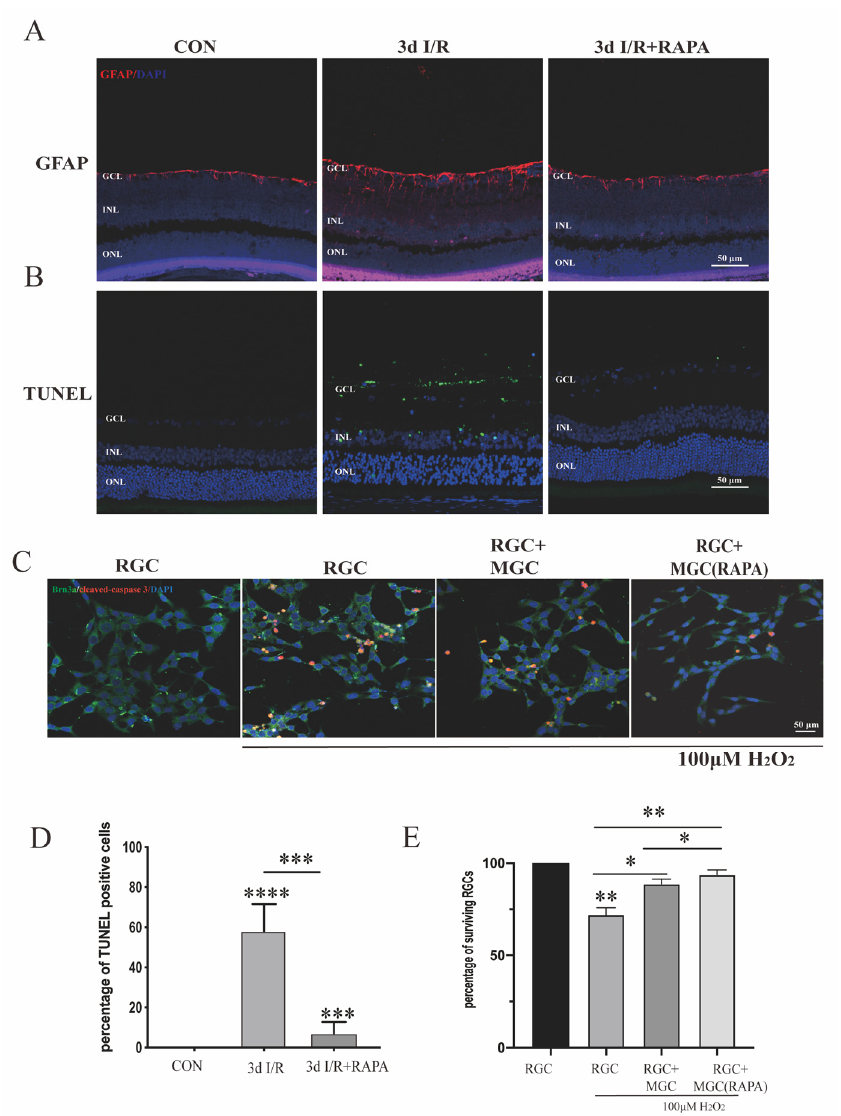
Figure 4. Rapamycin treatment can alleviate MGC gliosis and retinal cell apoptosis. ( A ) GFAP immunostaining in rat retina, in control, ischemia-reperfusion, and ischemia-reperfusion plus ra- pamycin groups (scale bar: 50 µ m). ( B ) TUNEL staining in rat retina, in control, ischemia-reperfusion, and ischemia-reperfusion plus rapamycin groups (scale bar: 50 µ m). ( C ) Brn3a and cleaved